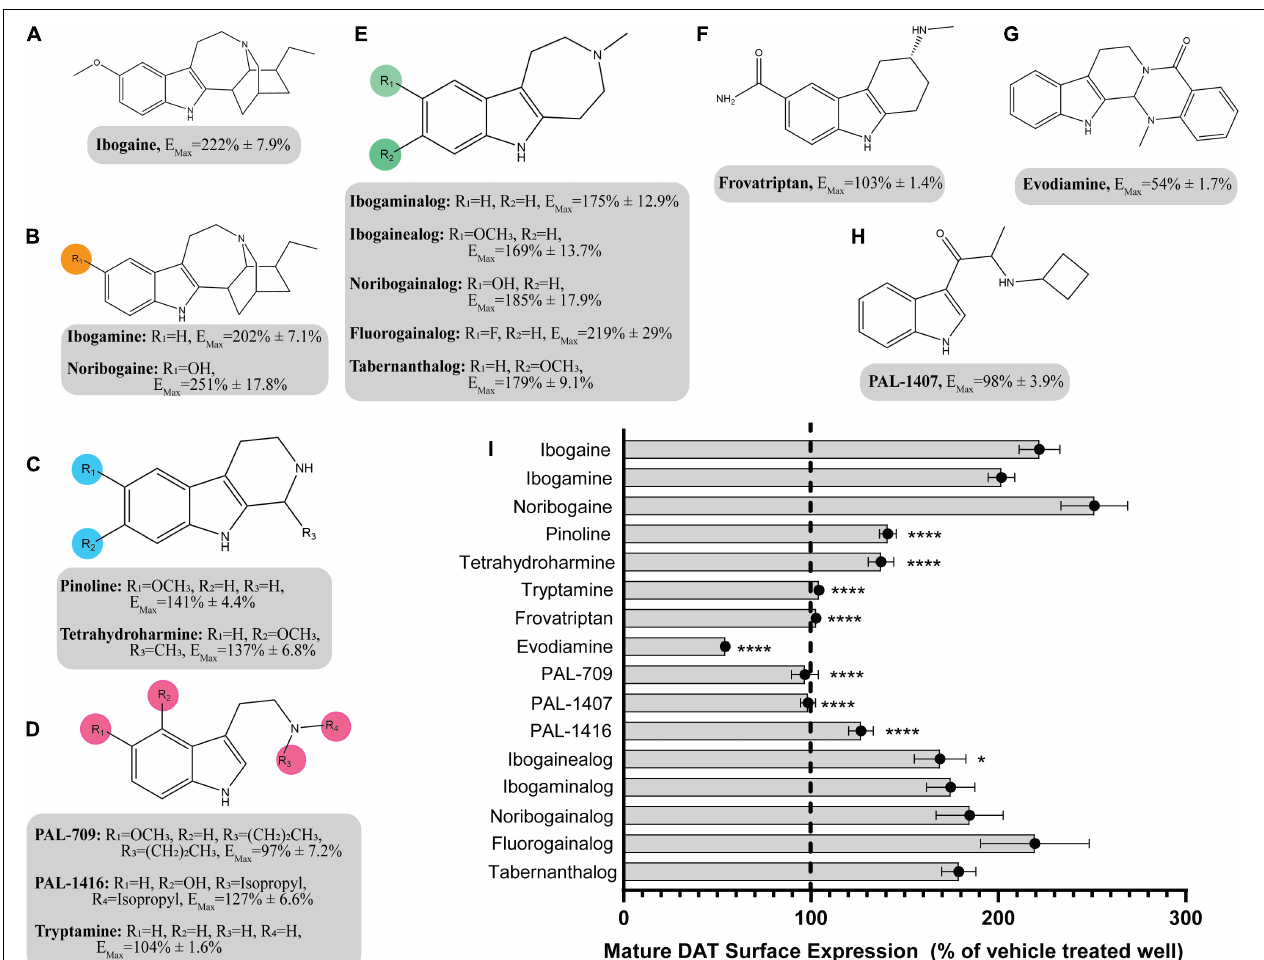
FIGURE 3 | Structures of ibogaine analogs and their effects (E Max ) on WT DAT surface expression. (A) Structure and E Max of ibogaine. (B) Ibogaine analogs. E Max included for each compound. (C) The β Carbolines. E Max included for each compound. (D) Tryptamine analogs. E Max included for each compound. (E) Analogs without the isoquinuclidine substituent. E Max included for each compound. (F) Structure and E Max of frovatriptan. (G) Structure and E Max of evodiamine. (H) Structure and E Max of PAL-1407. (I) Bar graph of ibogaine analogs E Max (**** p < 0.0001 and * p < 0.05, one-way ANOVA compared to ibogaine with Dunnett’s test). Analogs are grouped in gray boxes based on similarities to the ibogaine backbone. Data were normalized to vehicle